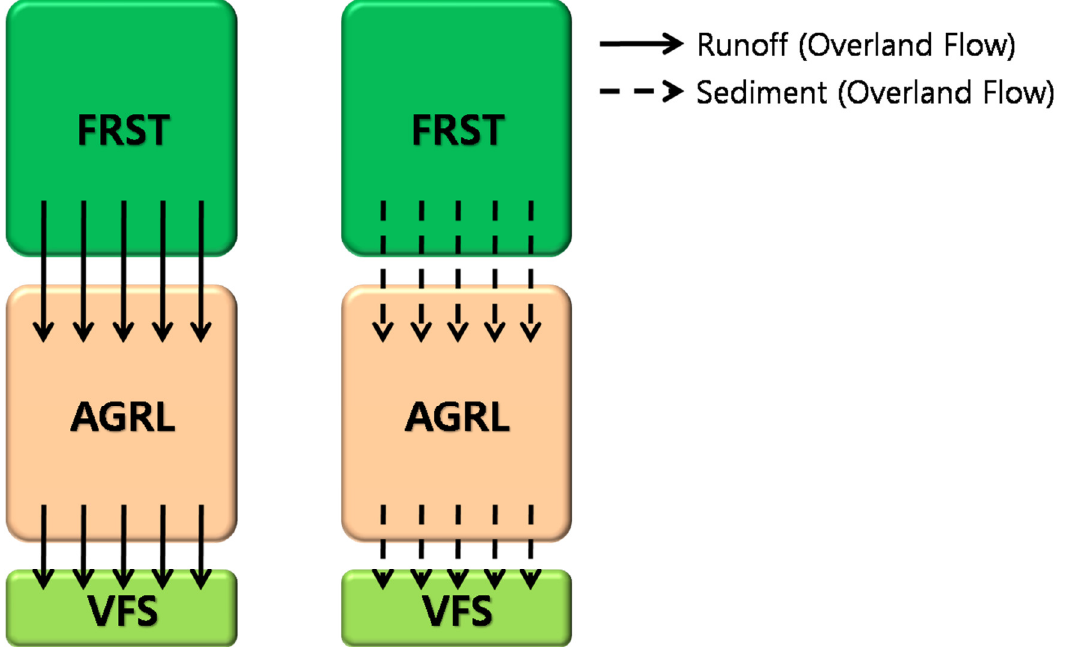
Figure 4. Proposed Runoff and Sediment Simulation reflecting spatially-explicit